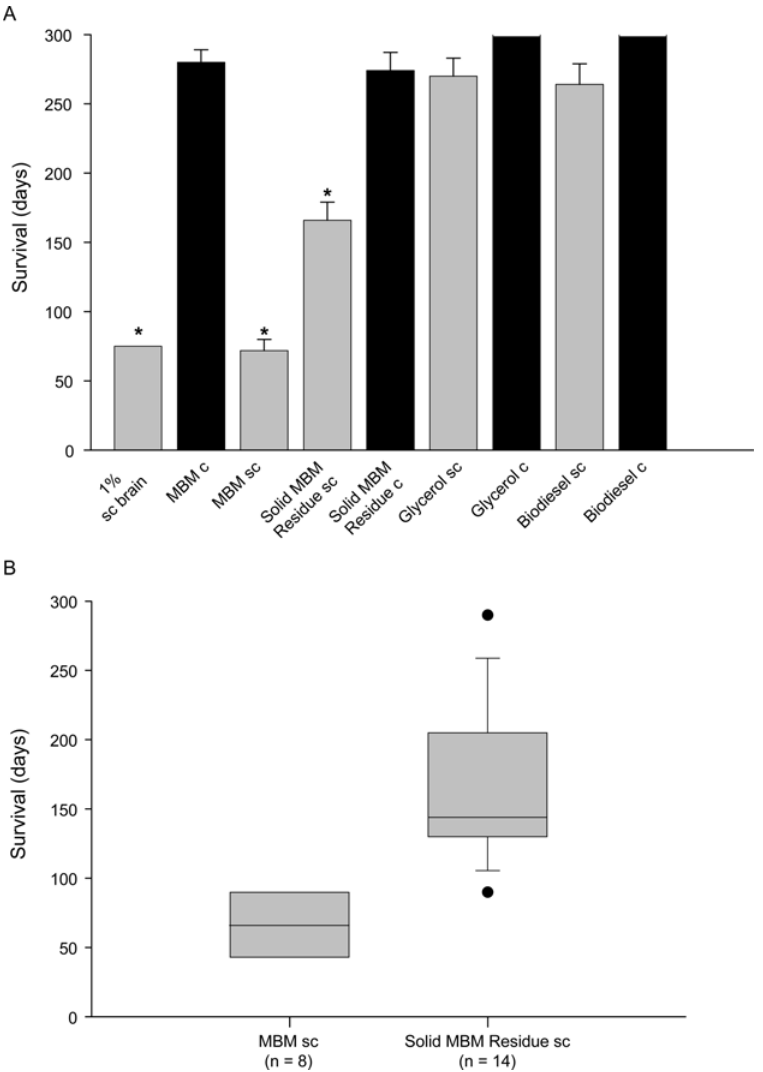
Figure 3. Infectivity bioassay. (A) Control animals inoculated with 50 m l 1% scrapie BH exhibited clinical symptoms 75 days after inoculation and were sacrificed (1% sc brain). Animals inoculated with MBM sc began to display clinical symptoms around 75 days post inoculation and were sacrificed when moribund. All animals inoculated with Solid MBM Residue sc developed disease (166 + / 2 13 days), even though no PrP sc was detected by Western Blot in initial inoculum. Survival time of animals from all 3 groups was significantly shorter as compared to control animals (control: MBM c and Solid MBM Residue c; p , 0.05; ANOVA on ranks). Animals inoculated with Biodiesel sc and Glycerol sc displayed no clinical symptoms within the time frame of the experiment ( . 200 days). Survival was comparable to control group animals (Biodiesel c, Glycerol c). Days of survival are calculated as mean values. (B) The range of time-to death values of hamsters inoculated with MBM sc and Solid MBM Residue sc is summarized showing the median, upper and lower quartiles and extreme values (outliers) for comparison of both